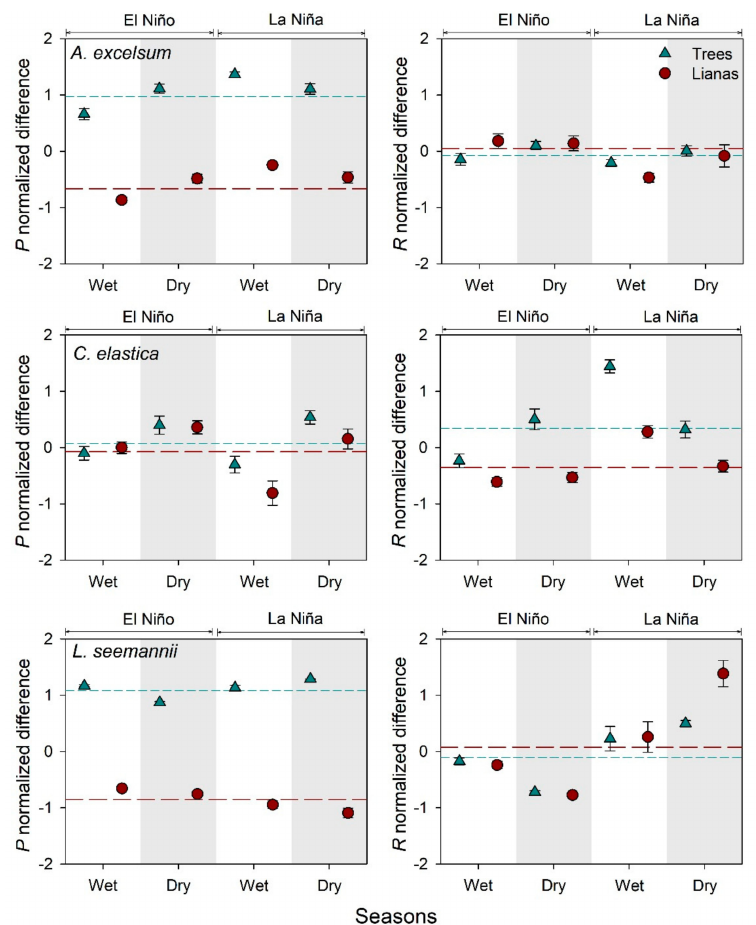
Figure 3. Normalized differences of predictions of photosynthesis ( P ) and leaf dark respiration ( R ) of leaves of trees and lianas on four host species during the wet and dry season in contrasting ENSO years. Each point represents the mean ( ± SE). Short dashed lines represent the mean for trees, while long dashed lines represent the mean for